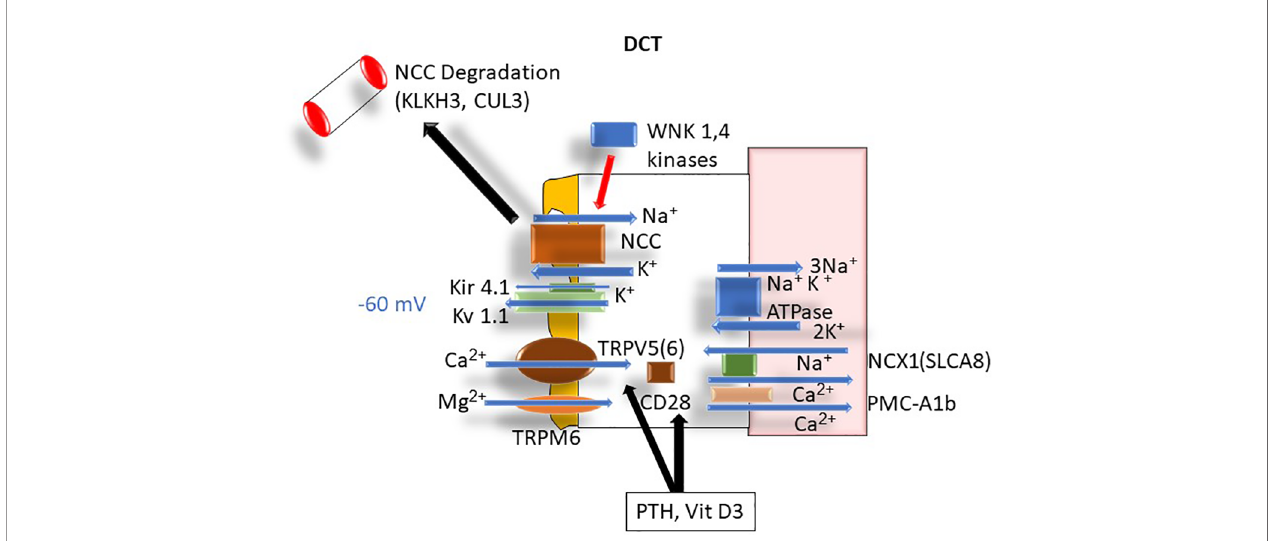
FIGURE 6 | DCT Ca 2+ transport: ATPase, adenosine triphosphatase; Ca 2+ , calcium; CD28, cellular determinant 28 (Calbindin); CUL3, cullin 3; DCT, distal convoluted tubule; K + , potassium; Kir 4.1, inwardly rectifying potassium channel; KLHL3, Kelch-like protein 3 ; Kv 1.1, apical potassium channel 1.1; Na + , sodium;